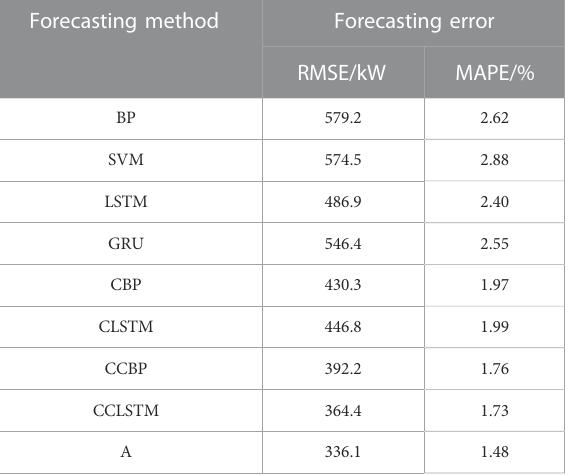
TABLE 5 Single time step forecasting error of different methods.